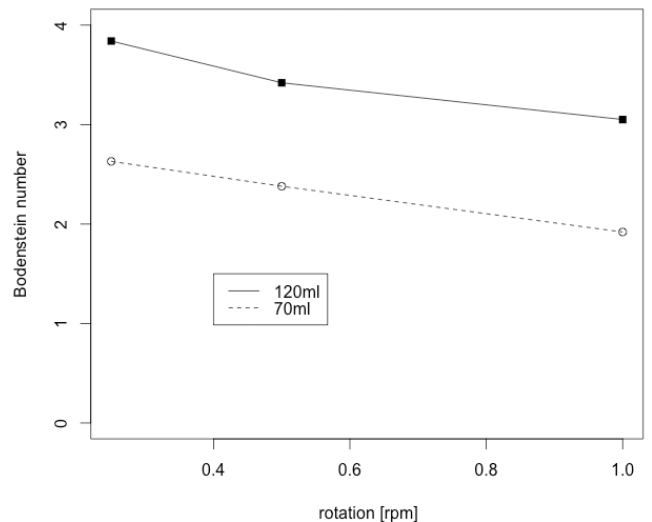
Figure 5. Bodenstein numbers of Z ® RP 2000 H rotating bed bioreactor. Bodenstein number indicate a high backmixing within the